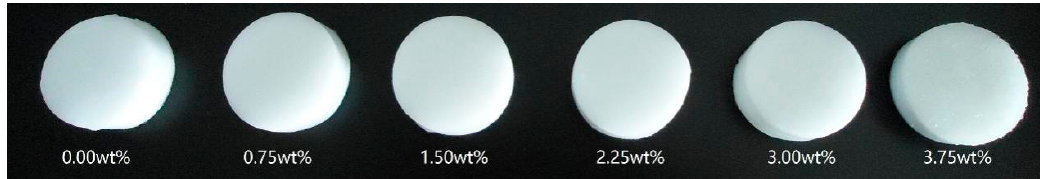
Figure 1. Images of the PVA/FG composite hydrogel with different fish gelatin (FG) contents.